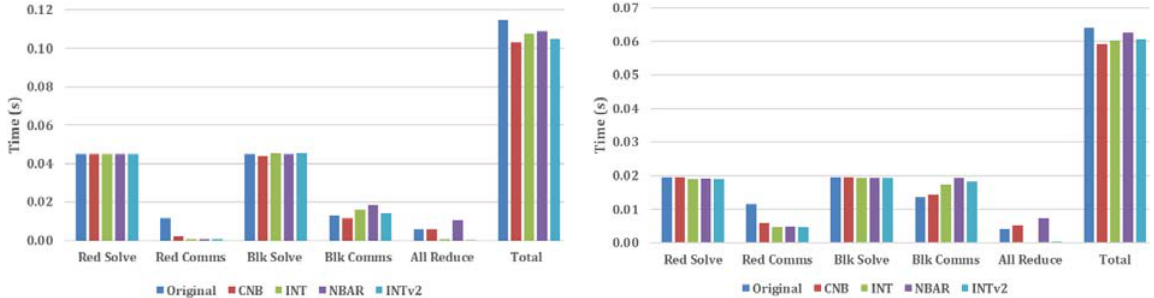
Figure 4: Version Comparison at p = 32K, RB4 Figure 5: Version Comparison at p = 32K,